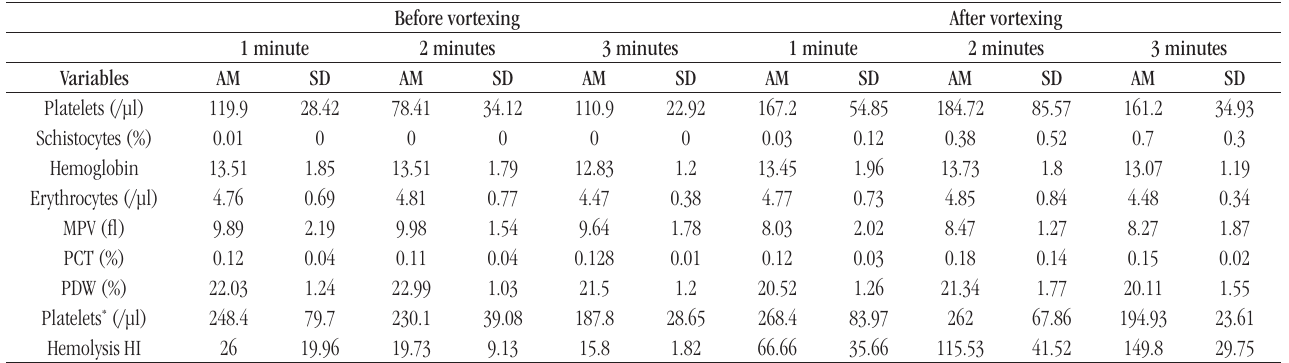
taBLE 1 − Analysis of central tendency and dispersion of pre- and post-vortexing studied variables Before vortexing After